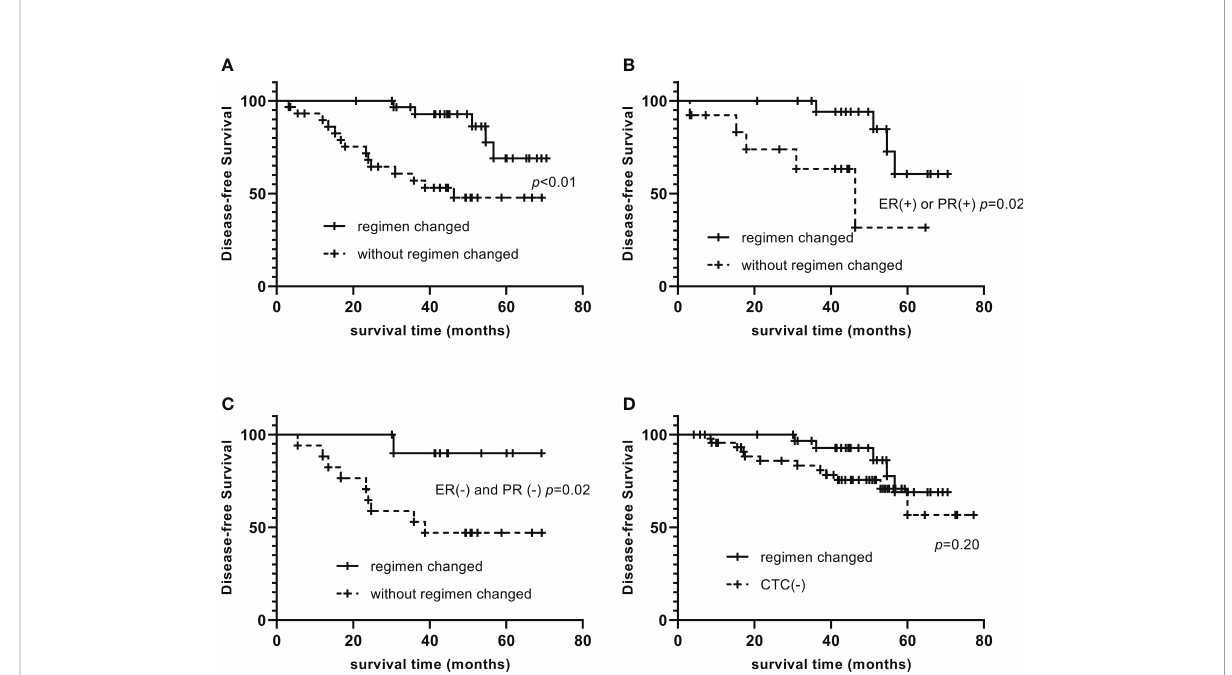
FIGURE 1 Impact of changing the therapeutic regimen on the prognosis of CTC-positive patients Compare of DFS between patients who changed the treatment strategy and who did not (A) . Among them, CTC-positive and ER-positive or PR-positive patients, those who changed endocrine therapy drugs had signi fi cantly longer DFS than those who did not change (B) . Among CTC-positive and ER-negative and PR-negative patients, DFS of capecitabine users were signi fi cantly longer than that of non-users (C) . By changing the treatment regimen, there was no signi fi cant difference in DFS between CTC-positive patients and CTC-negative patients (D)